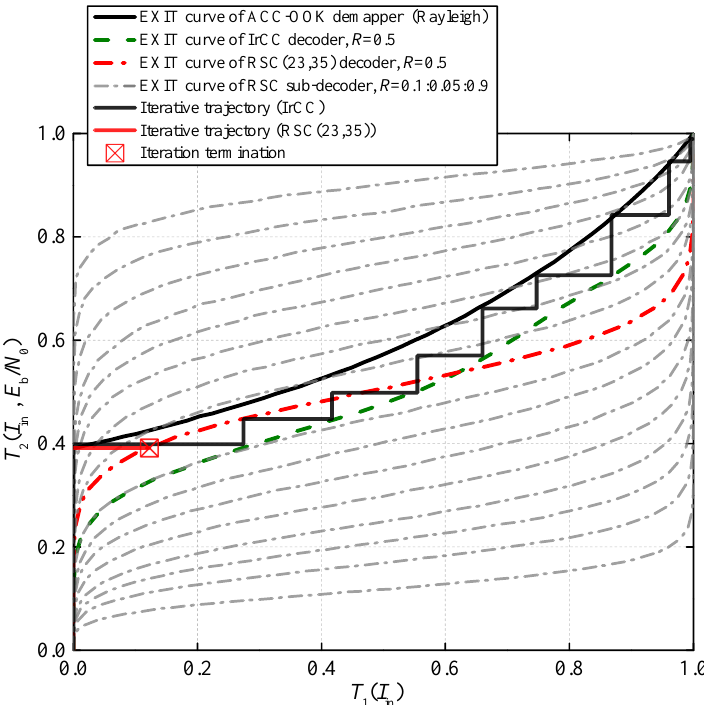
Figure 5. Iteration trajectory of the system using IrCC under the Rayleigh fading channel, E b / N 0 = 11.3